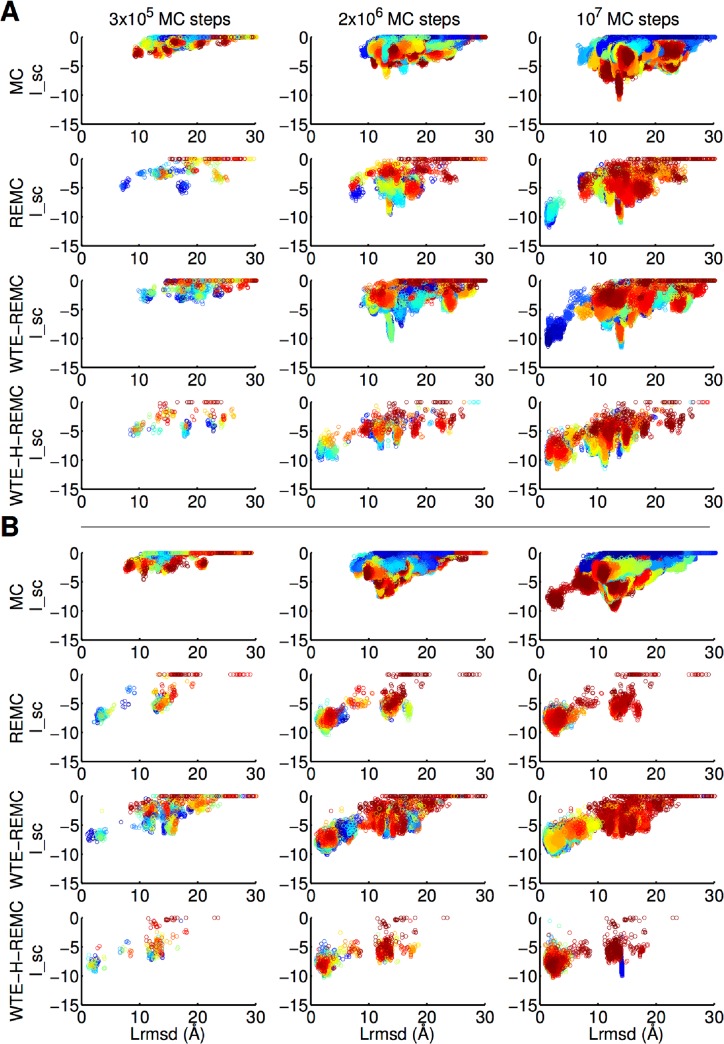
Scatter plot of interaction score I_sc (Rosetta units) vs. L_rmsd (Å) for the four docking refinement protocols and two representative targets, 1EAW (A) and 3SGQ (B).The protocol is indicated on the left for each row of plots. The snapshots number is color-coded, that means blue and red dots corresponding to decoys sampled at the beginning and the end of the docking searches in each panel, respectively. The three columns of plots indicate the result after different simulation lengths (indicated on top of each column).